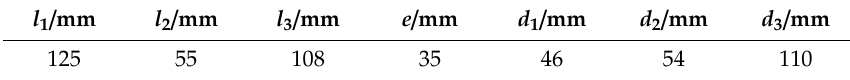
Figure 2. Sketch of the Origaker II. Table 1. parameters of the metamorphic